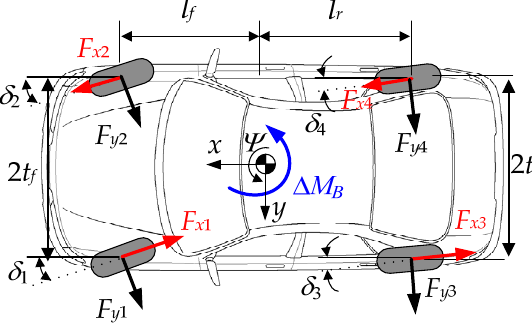
Figure 4. Coordinate system corresponding to tire forces and control yaw moment.